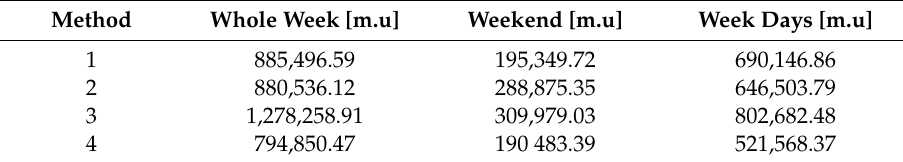
Table 5. Remuneration